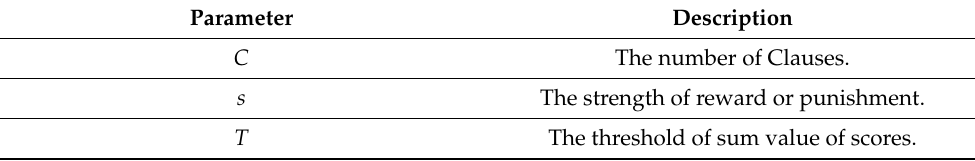
Table 8. Description of